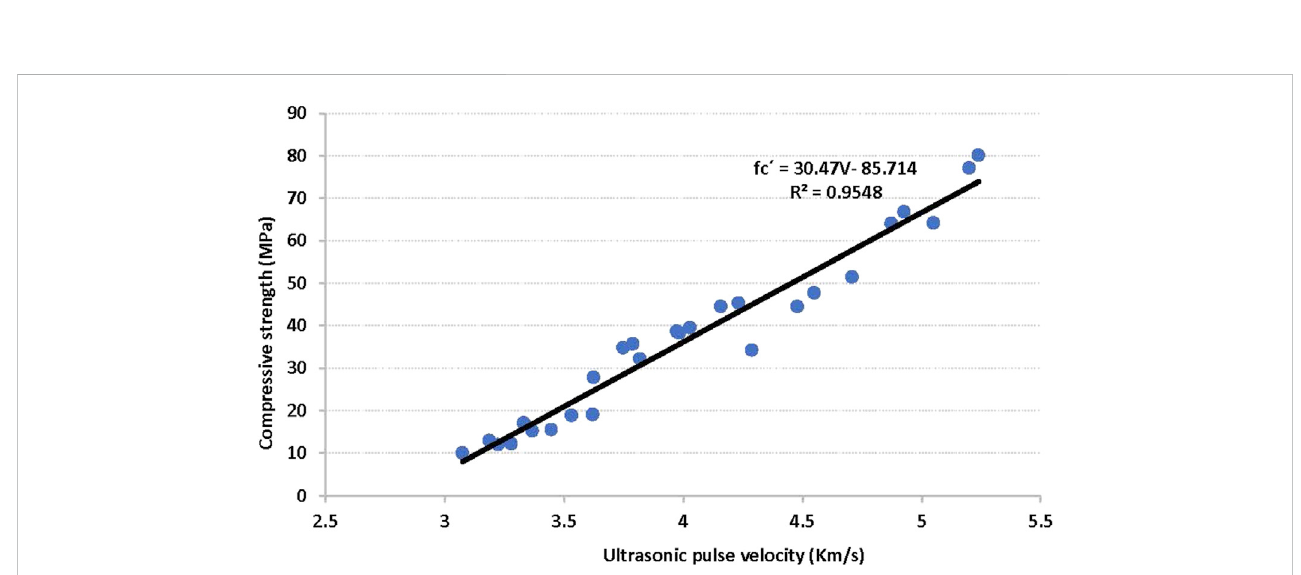
The relationship between the properties of concrete for its compressive strength and UPV at 7, 28, and 90